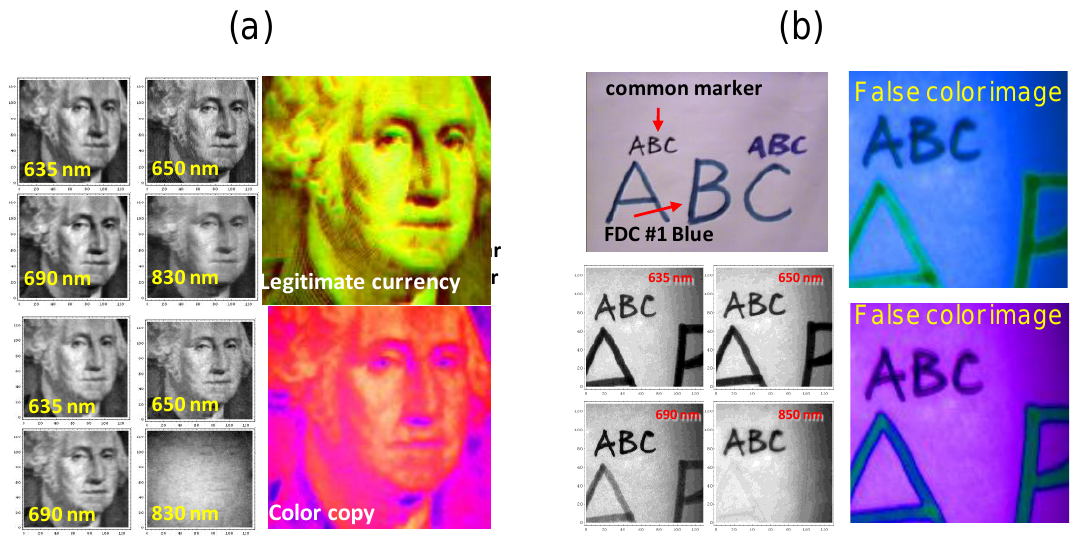
Figure 14. Example of spectral images with features that allow strong discrimination [27]. (a) Legitimate US currency (top left 4 images) vs. its color photocopy (bottom left 4 images). The false color images (FCI) right top and bottom are discriminated mainly on the 830 nm spectral images. (b) Similar experiments on common marker dark blue ink vs . FDC#1 blue. The two FCI’s show their spectral difference and detailed variation within the large